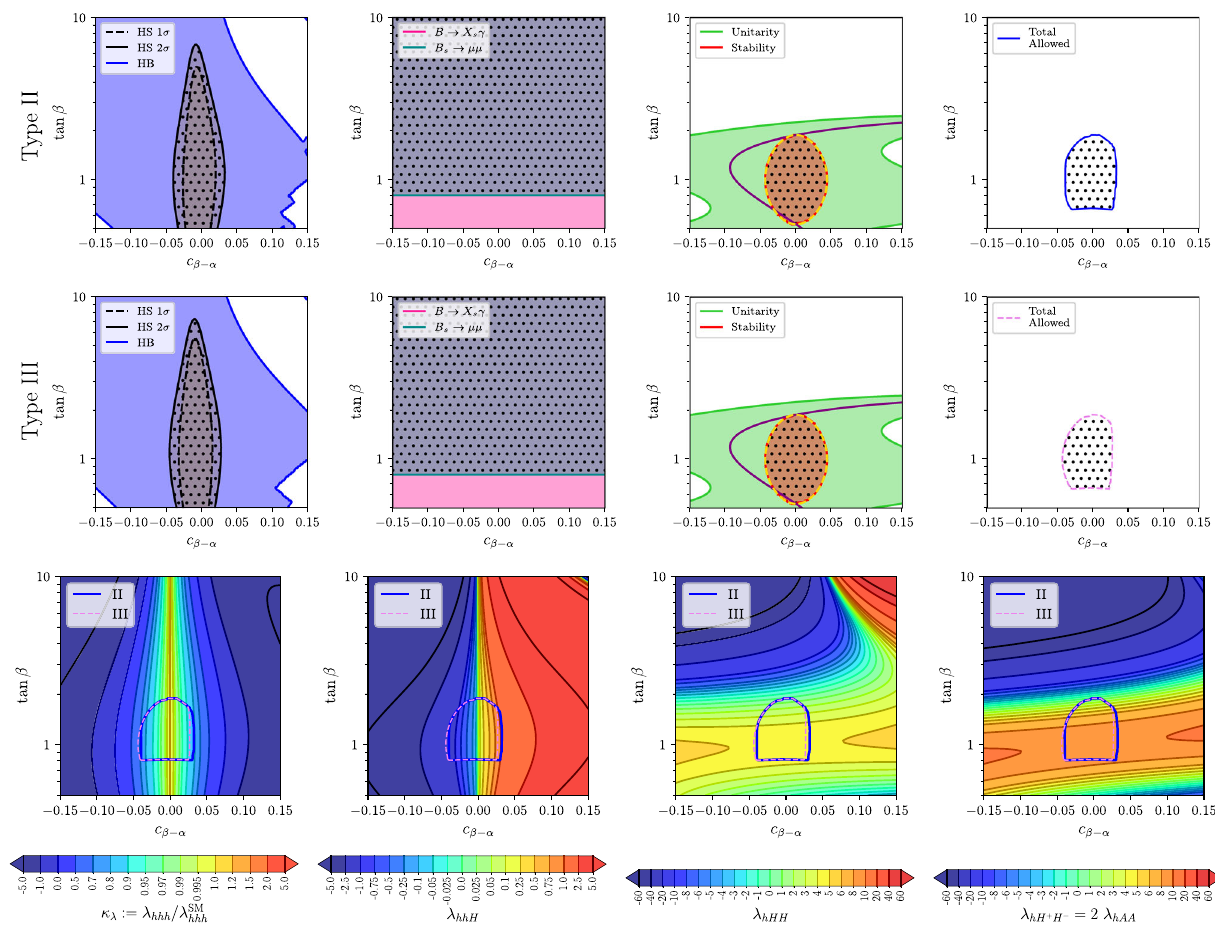
Fig. 10 Allowed areas (dotted regions) from the various constraints in type II (upper row) and type III (middle row) and triple Higgs couplings (lower row) for the benchmark scenario II/III-3 in the c β − α –tan β plane with m ≡ m H = m A = m H ± = 1300 GeV and m 2